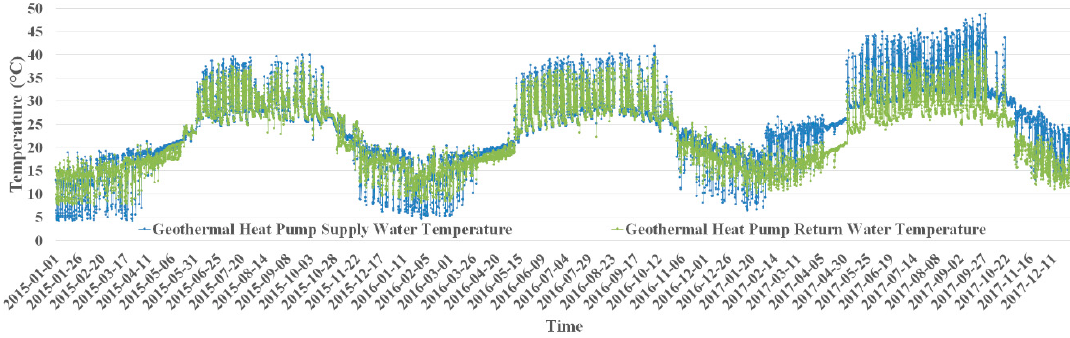
Figure 2. Source side temperature.